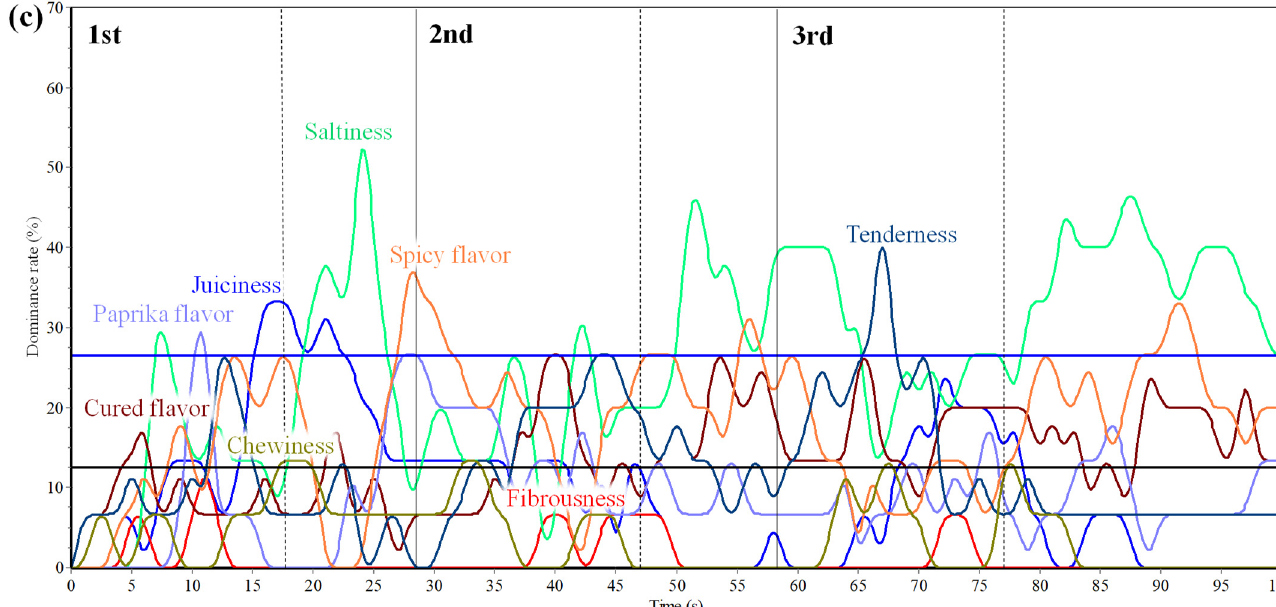
Figure 4. Multiple-intake TDS dominance curves of eight sensory attributes during three intakes of GL ( a ); RL ( b ); BL ( c ) dry cured loins (GL = green label, Cebo de Campo Ibérico dry-cured loin; RL = red label, Bellota 50% Ibérico dry-cured loin; BL= black label, Bellota 100% dry-cured loin). Two horizontal lines account for chance level ( ▬ ) and significance level ( ▬ ) and two vertical lines indicate the time of each intake ( ─ ) and the moment of swallowing (---).